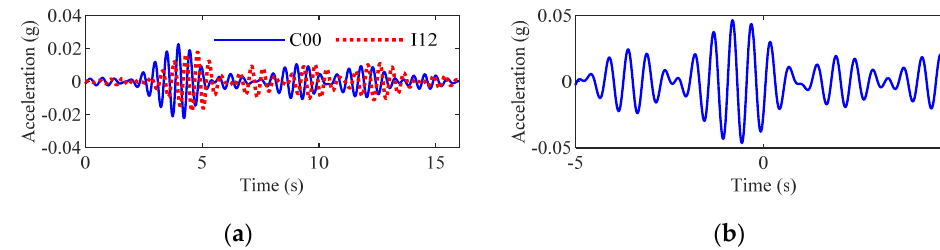
Figure 14. ( a ) Filtered accelerations for accelerations at stations C00 and I12 when ω 0 = 2 Hz, and ( b ) cross-correlation of the filtered accelerations.